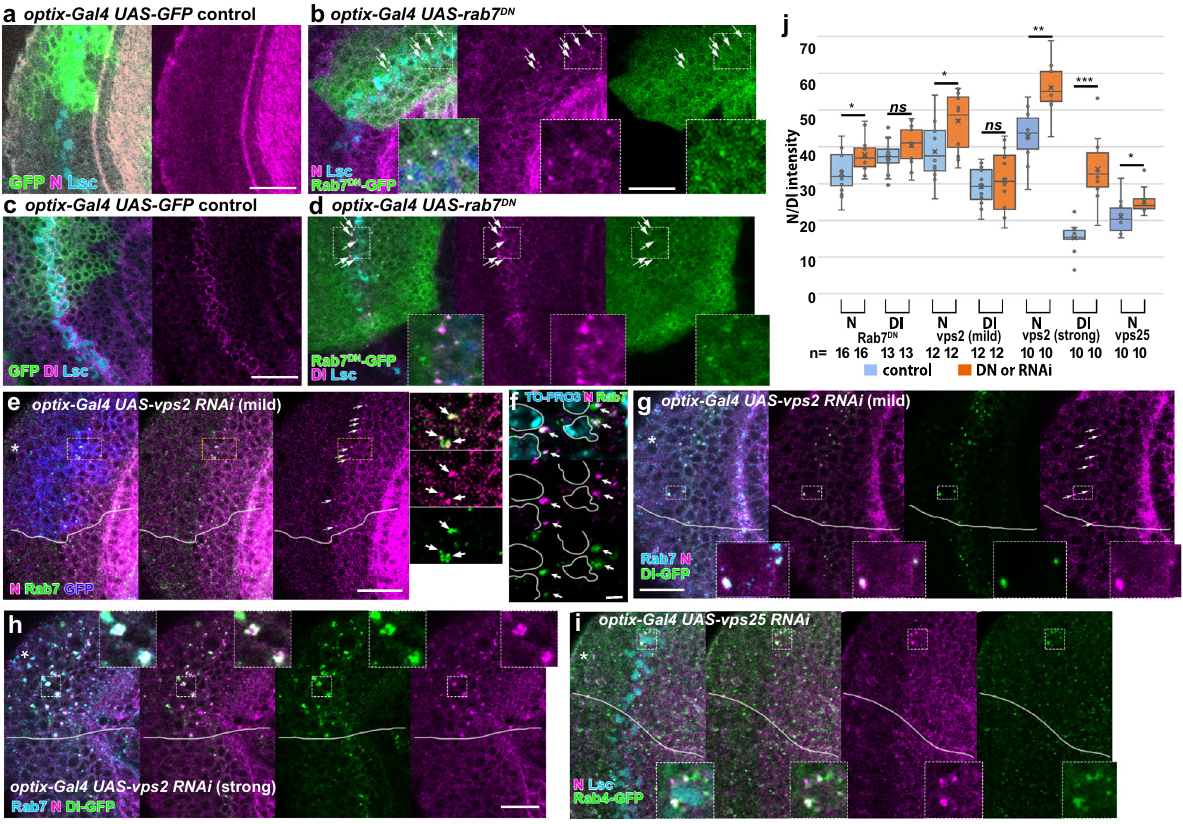
Fig. 4 Late endosomes are responsible for Notch degradation at the wavefront. a – d Expression of UAS-rab7 DN -GFP under the control of optix-Gal4 (green) induces ectopic puncta of N (magenta in a , b ) and Dl (magenta in c , d ) colocalized with Rab7 DN -GFP (green, arrows) at the wavefront (Lsc, blue). The puncta of N and Dl are not detected in the controls ( a , c ). e – h vps2 RNAi under the control of optix-Gal4 induces ectopic puncta of N (magenta) at the wavefront (arrows) in the areas indicated by asterisks (marked by UAS-CD8GFP expression in e ). The N puncta are colocalized with Rab7 (green in e , f ; blue in g , h ) and Dl-GFP (green in g , h ). Mild and strong phenotypes are shown in ( e – g ) and ( h ), respectively. The N puncta are found outside the nucleus (TO-PRO3, blue). i vps25 RNAi under the control of optix-Gal4 induces ectopic puncta of N (magenta) that colocalize with Rab4-GFP (green) at the wavefront (arrows). The white dotted box area is enlarged in the right panels in ( e , g – i ). Scale bars indicate 20 μ m in ( a – e , g – i ) and 2 μ m in ( f ). j Quanti fi cation of the signal intensities of N and Dl ( p = 0.008, 0.108, 0.180, 0.613, 0.0009, 0.0001, 0.042 (* p < 0.05, ** p < 0.01, *** p < 0.001, n.s. not signi fi cant), two-sided t test). The number of quanti fi ed areas is indicated. Cross, mean; center line, median; box limits, upper and lower quartiles; whiskers, 1.5× interquartile